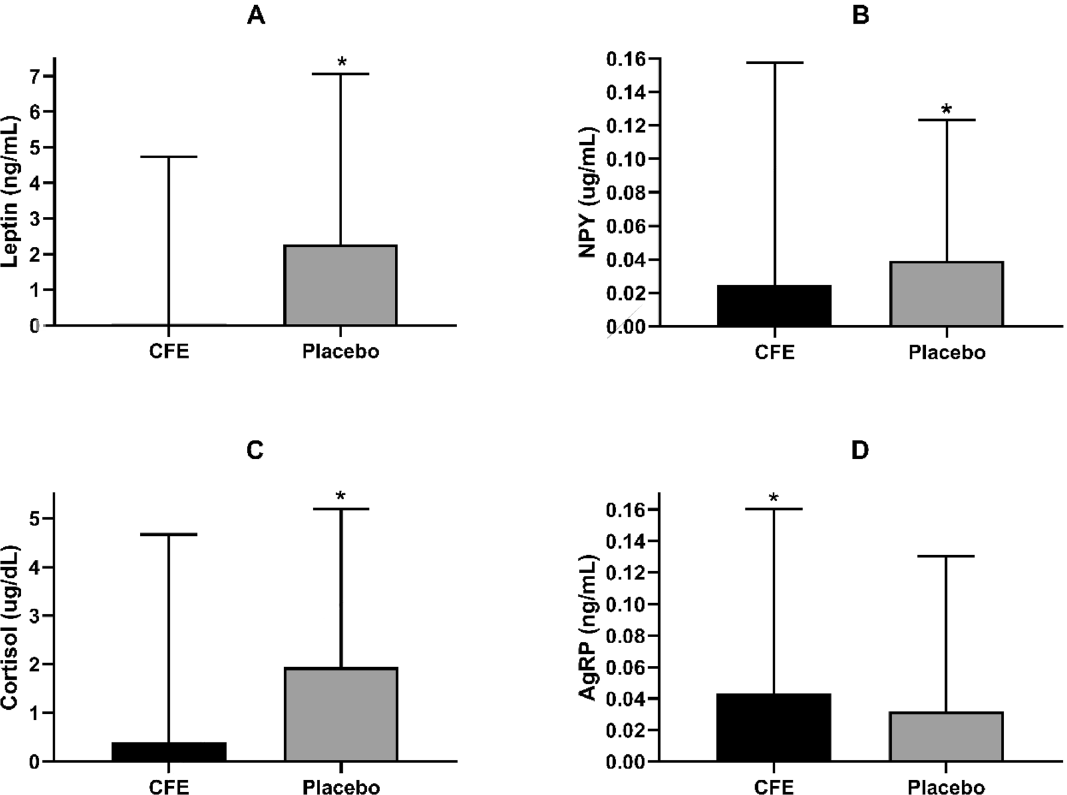
Figure 2. Change from baseline to week 16 for CFE and placebo groups. ( A ) plasma leptin concentration; ( B ) NPY concentration; ( C ) cortisol concentration; ( D ) AgRP concentration; Data presented as mean ± SD; CFE, Caralluma Fimbriata ; NPY, neuropeptide-Y; AgRP, agouti related peptide *significant difference between groups at p <